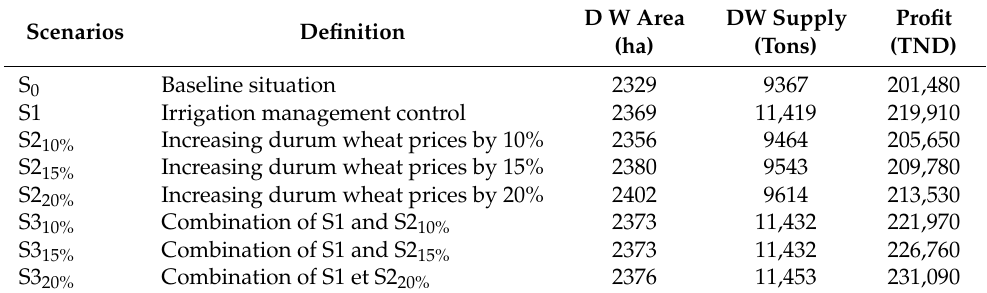
Table 7. Variation in DW area, DW supply, and profits under different